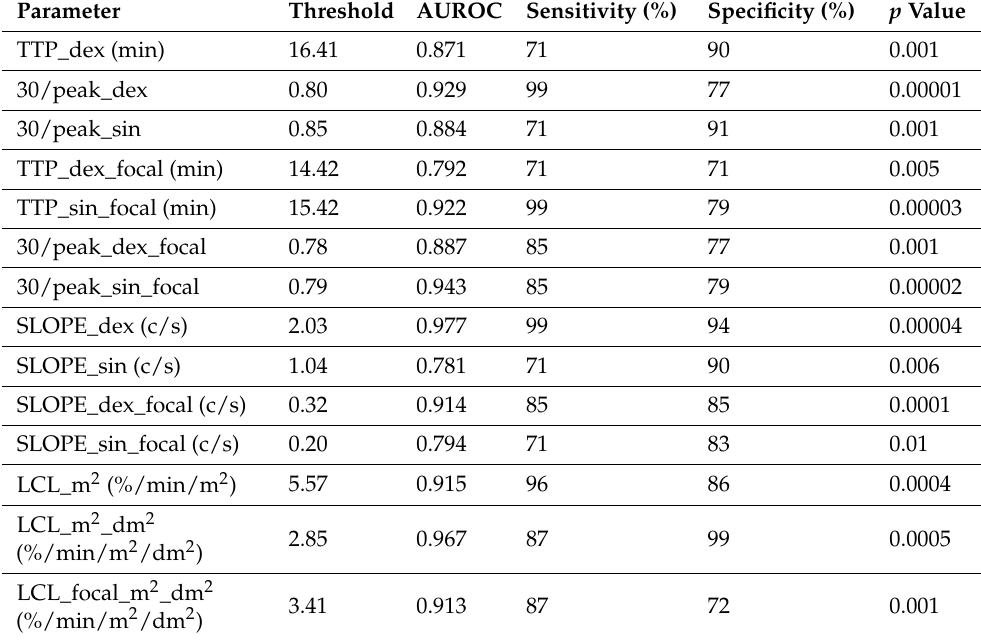
Table 5. Dynamic scintigraphic quantitative parameters discriminating cirrhosis (F1–F3 vs. F4).